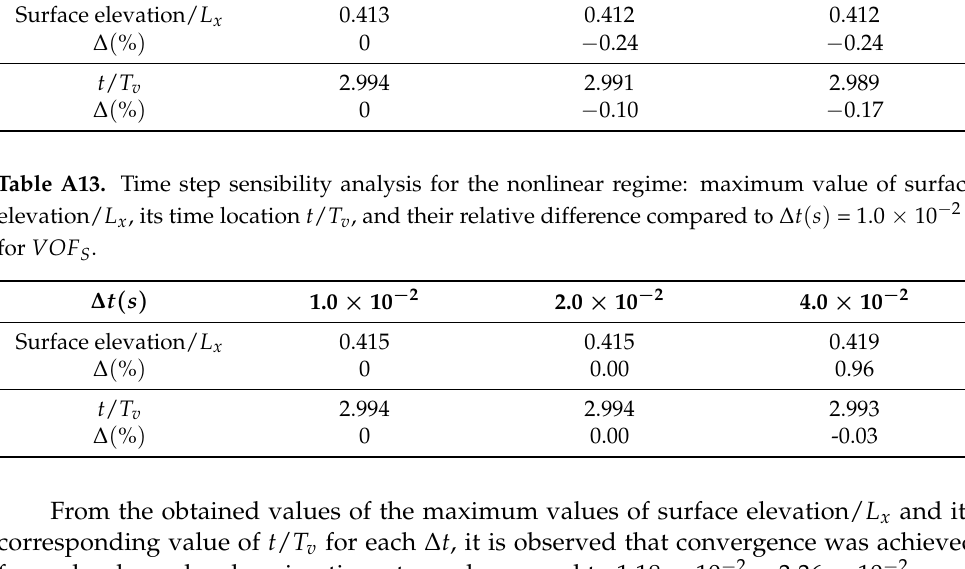
From the obtained values of the maximum values of surface elevation/ L x and its corresponding value of t / T v for each ∆ t , it is observed that convergence was achieved for each scheme by choosing time step values equal to 1.18 × 10 − 2 s, 3.36 × 10 − 2 s and 1.0 × 10 − 2 s for the EbFVM S , FT S and VOF S ,